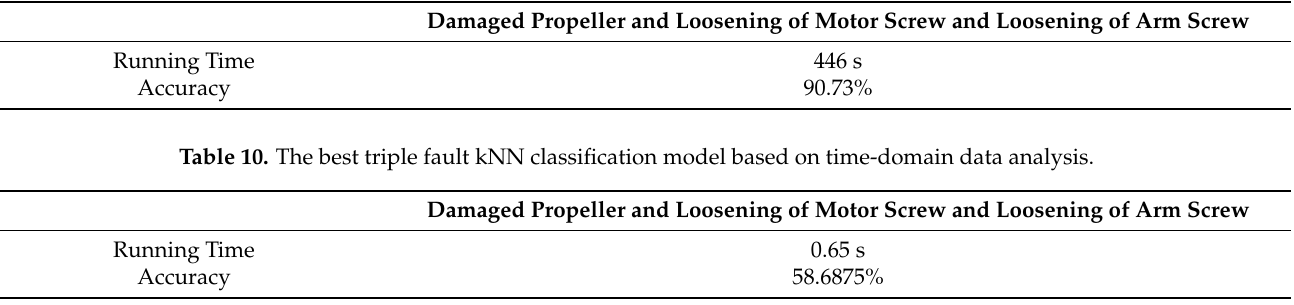
Table 9. The best triple fault kNN classification model based on time-frequency domain data analysis.